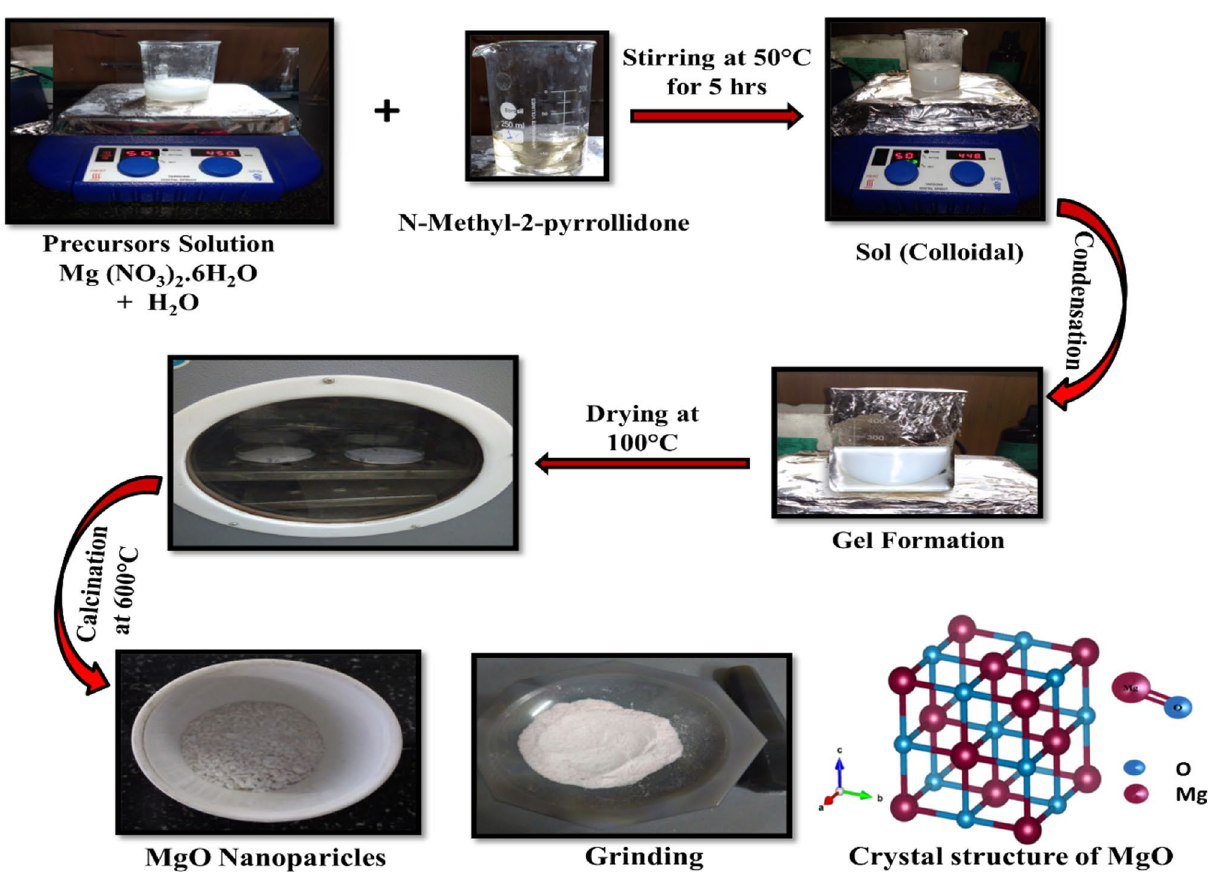
Figure 1. Schematic illustration showing the formation mechanisms of MgO nanoparticles via the sol–gel cooled to ambient temperature over, and giving ultrafine powder as a product. The obtained product of Ni- doped MgO nanoparticles had varying shades of gray color ranging from light to dark which varied according to the increase of the amount of Ni dopant. The formation mechanisms of MgO nanoparticles by the sol–gel method are illustrated in Fig. 1. Preparation of Co-doped MgO nanoparticles. Co-doped MgO nanoparticles were synthesized via the sol–gel process with the different concentrations of Co ions at low temperature. A mixture of Mg (NO 3 ) 2 ·6H 2 O (7 g), Co (NO and centrifuged at 5000 rpm. The gel product was heated at 100 °C in an oven for 72 h. All the samples were ground and annealed in the furnace at 600 °C for 4 h. Then it was allowed to be cooled to ambient temperature and obtained ultrafine powder. The ultrafine powder collected had various shades of gray color that varied from bright to deep-gray due to the increased Co dopant. Preparation of Fe doped MgO nanoparticles. Fe-doped MgO nanoparticles have been prepared by the sol–gel technique with the different concentrations of Fe ions. Mg (NO 3 ) 2 ·6H 2 O (7 g), Iron nitrate nonahydrate Fe (NO a viscous gel was formed. The gel was washed several times with distilled water and ethanol using centrifuging technique at a rate of 5000 rpm. The gel product was heated at 100 °C in an oven for 72 h. All the samples were placed into the furnace at 600 °C for 4 h. Then it was allowed to be cooled to ambient temperature. The obtained product of Fe-doped MgO nanoparticles had varying shades of brown color, which diverse according to the amount of Fe dopant from bright-brown to deep-brown.